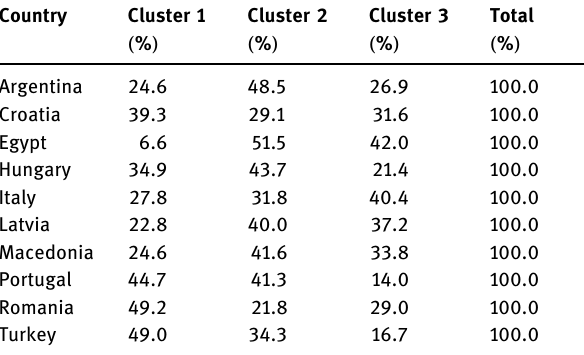
Table 11: Association between country and cluster membership Country Cluster 1 ( %